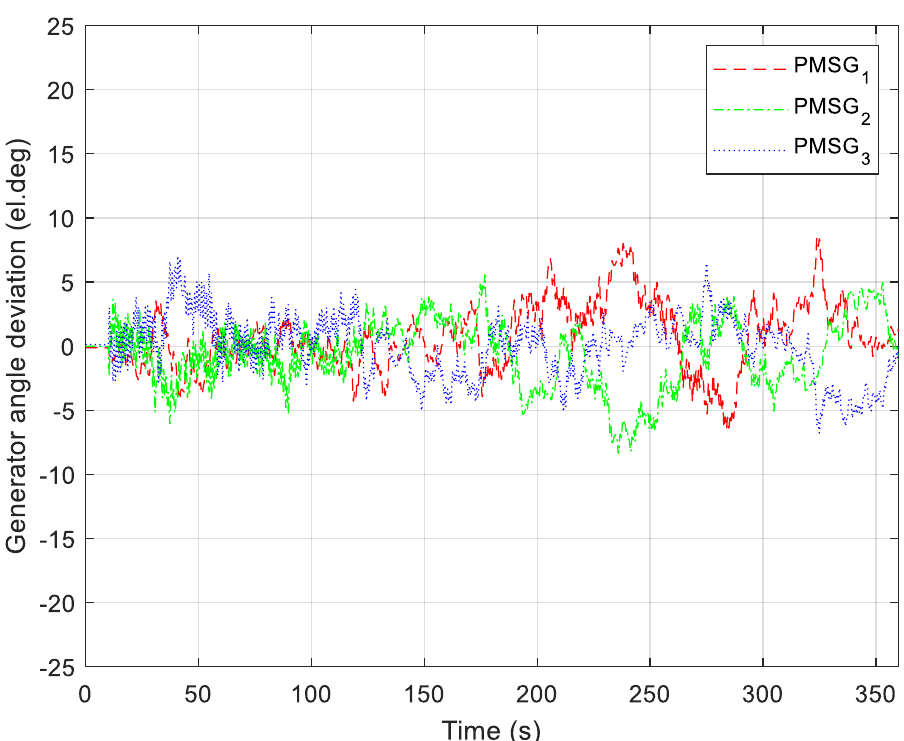
Figure 26. Deviations of rotor angles of PMSGs (random wind disturbance).